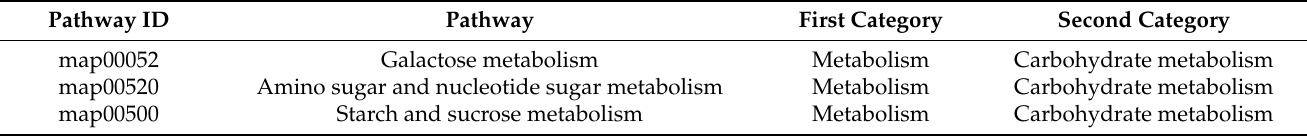
Table 4. KEGG metabolic pathways assigned to lily bulb polysaccharide-related